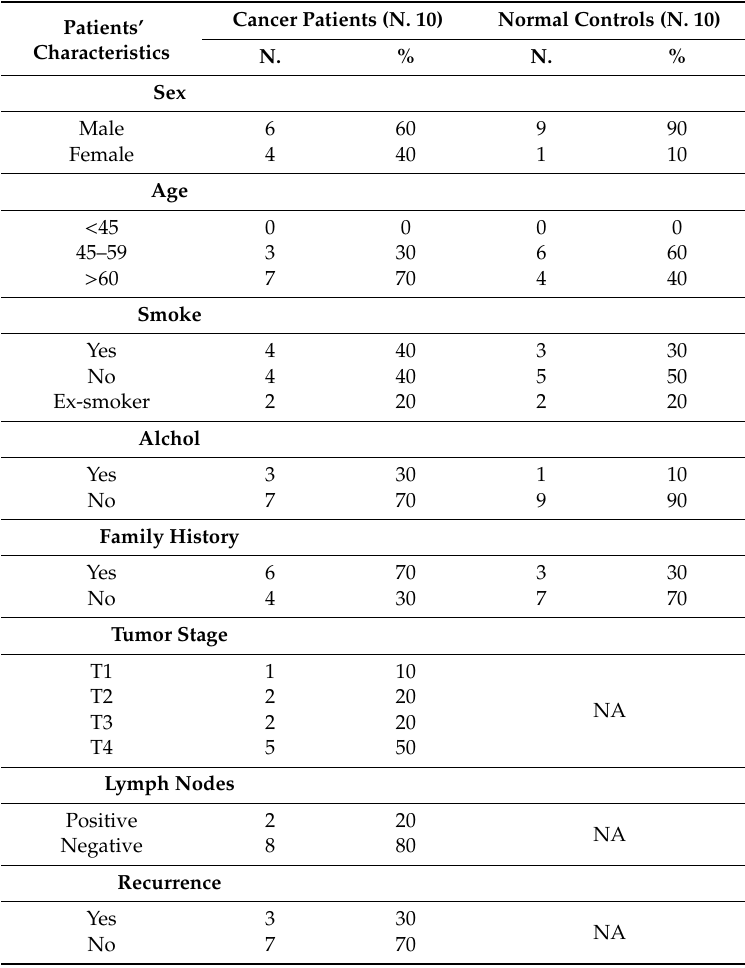
Table 1. Clinical pathological features of